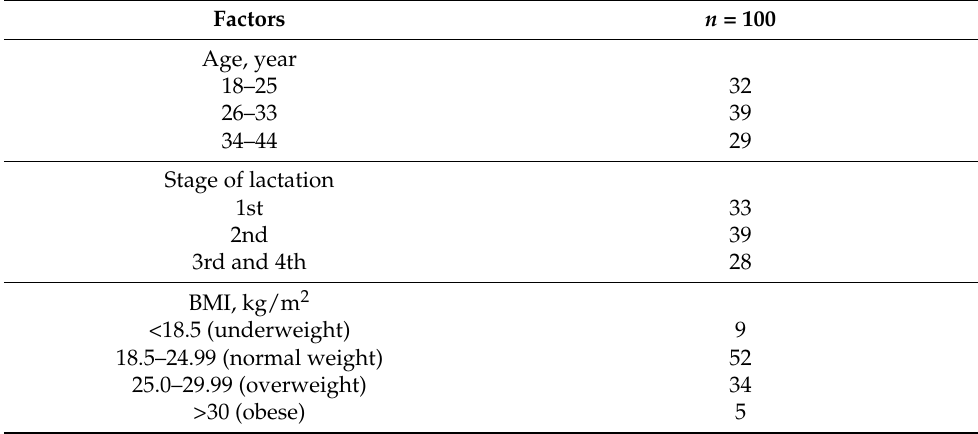
Table 1. Characteristics of the studied breastfeeding